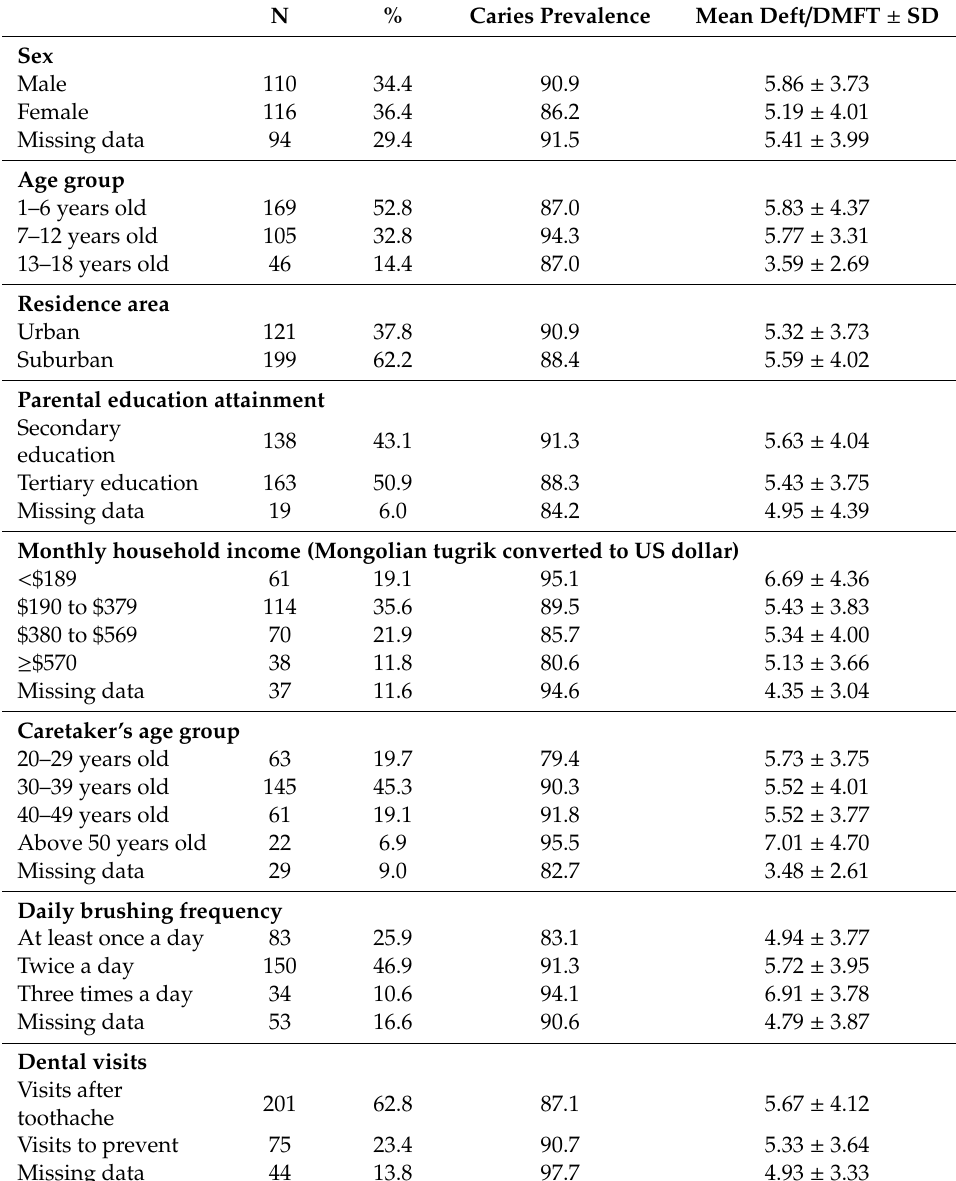
Table 1. Caries experience distribution by participants’